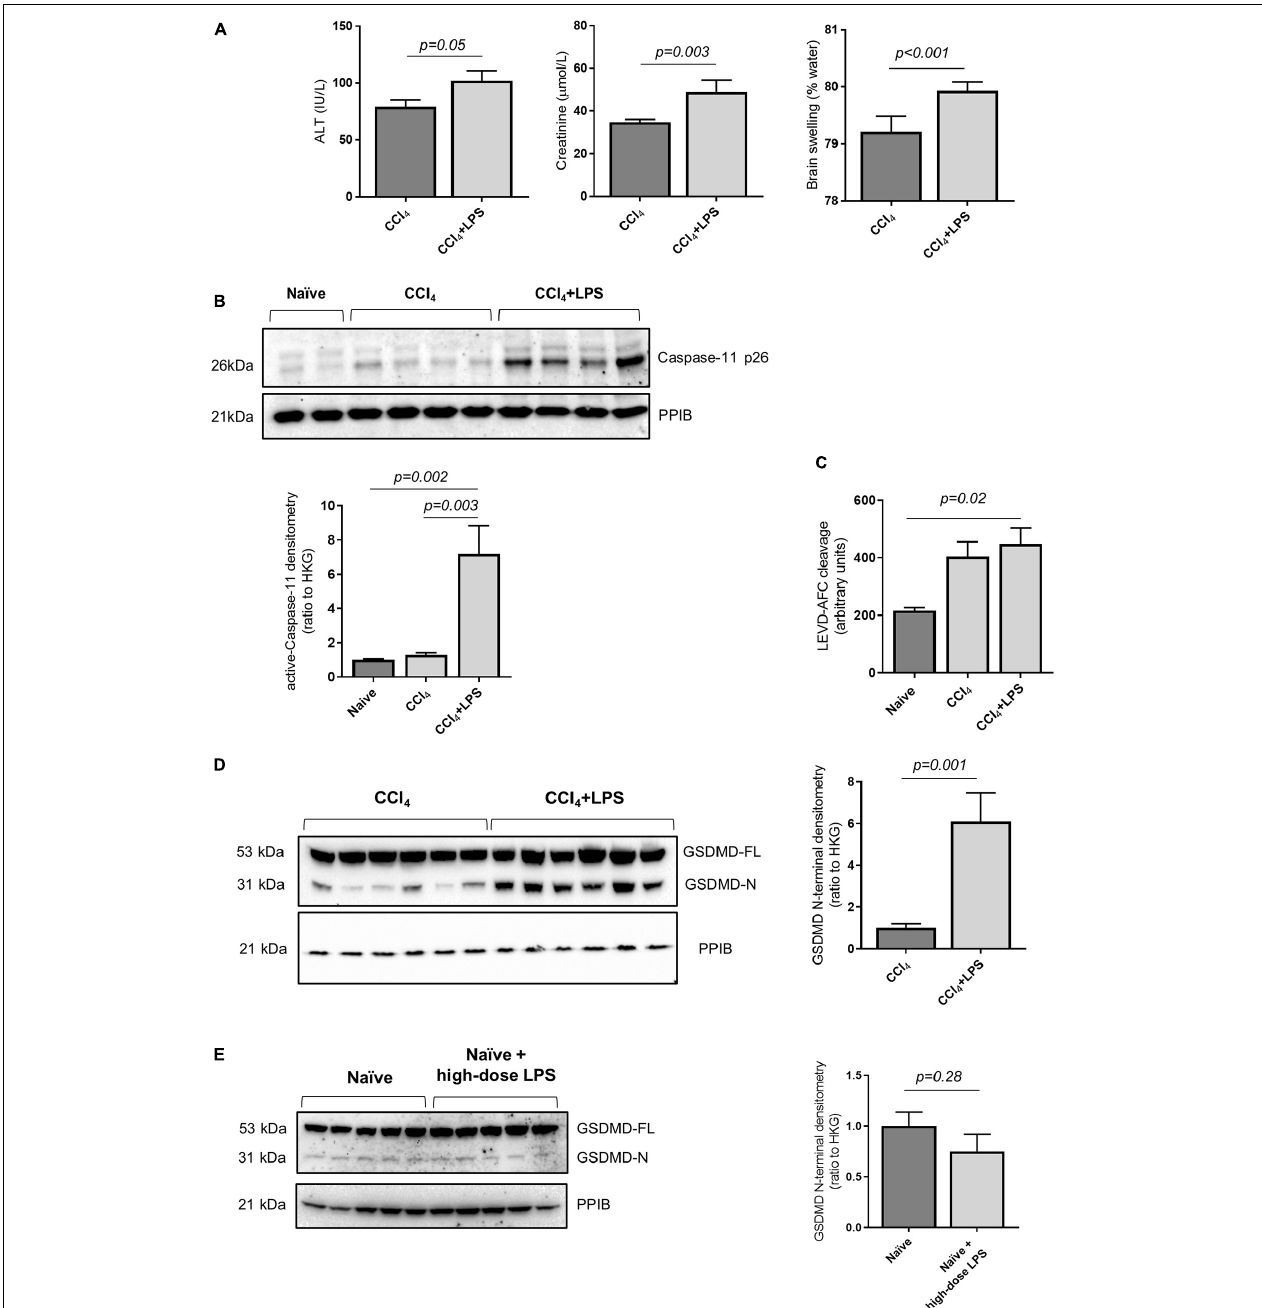
FIGURE 2 | Mouse model of decompensated liver cirrhosis displays activity of Caspase-11 and GSDMD cleavage. (A) Mice were treated with CCl 4 to develop advanced hepatic fibrosis. Following intraperitoneal injection of low-dose LPS (2 mg/kg), mice developed features of ACLF at 4 h ( n = 7/group). The CCl 4 + LPS group demonstrates elevated plasma ALT (left panel; Student’s t -test, p = 0.05), creatinine (center panel; Student’s t -test, p = 0.003) and brain swelling (right panel; Student’s t -test, p < 0.001). (B) Activation of caspase-11 was measured by relative abundance of active caspase-11 p26 compared to the housekeeping gene PPIB. CCl 4 + LPS treated mice ( n = 7; n = 6 showed in the image) showed higher levels of caspase-11 p26 than naïve mice ( n = 5) and mice treated with CC 4 alone (one-way ANOVA with Tukey post hoc test; p = 0.002 and p = 0.003, respectively). (C) The enzymatic cleavage of LEVD-AFC substrate in snap-frozen liver extracts showed a trend toward increase in the CCl 4 group, and was significantly elevated in CCl 4 + LPS-treated mice ( n = 7) compared to naïve animals ( n = 5) (one-way ANOVA with Tukey post hoc test p = 0.02). (D) Compared to animals treated with CCl 4 alone, the CCl 4 + LPS group shows higher expression of active GDSMD, measured as abundance of cleaved GSDMD N-terminal (Student’s t -test, p = 0.001). (E) There is no apparent increase in hepatic GSDMD activation in naïve mice or naïve mice treated with high-dose LPS (12 mg/kg) groups (Student’s t -test, p = 0.28).